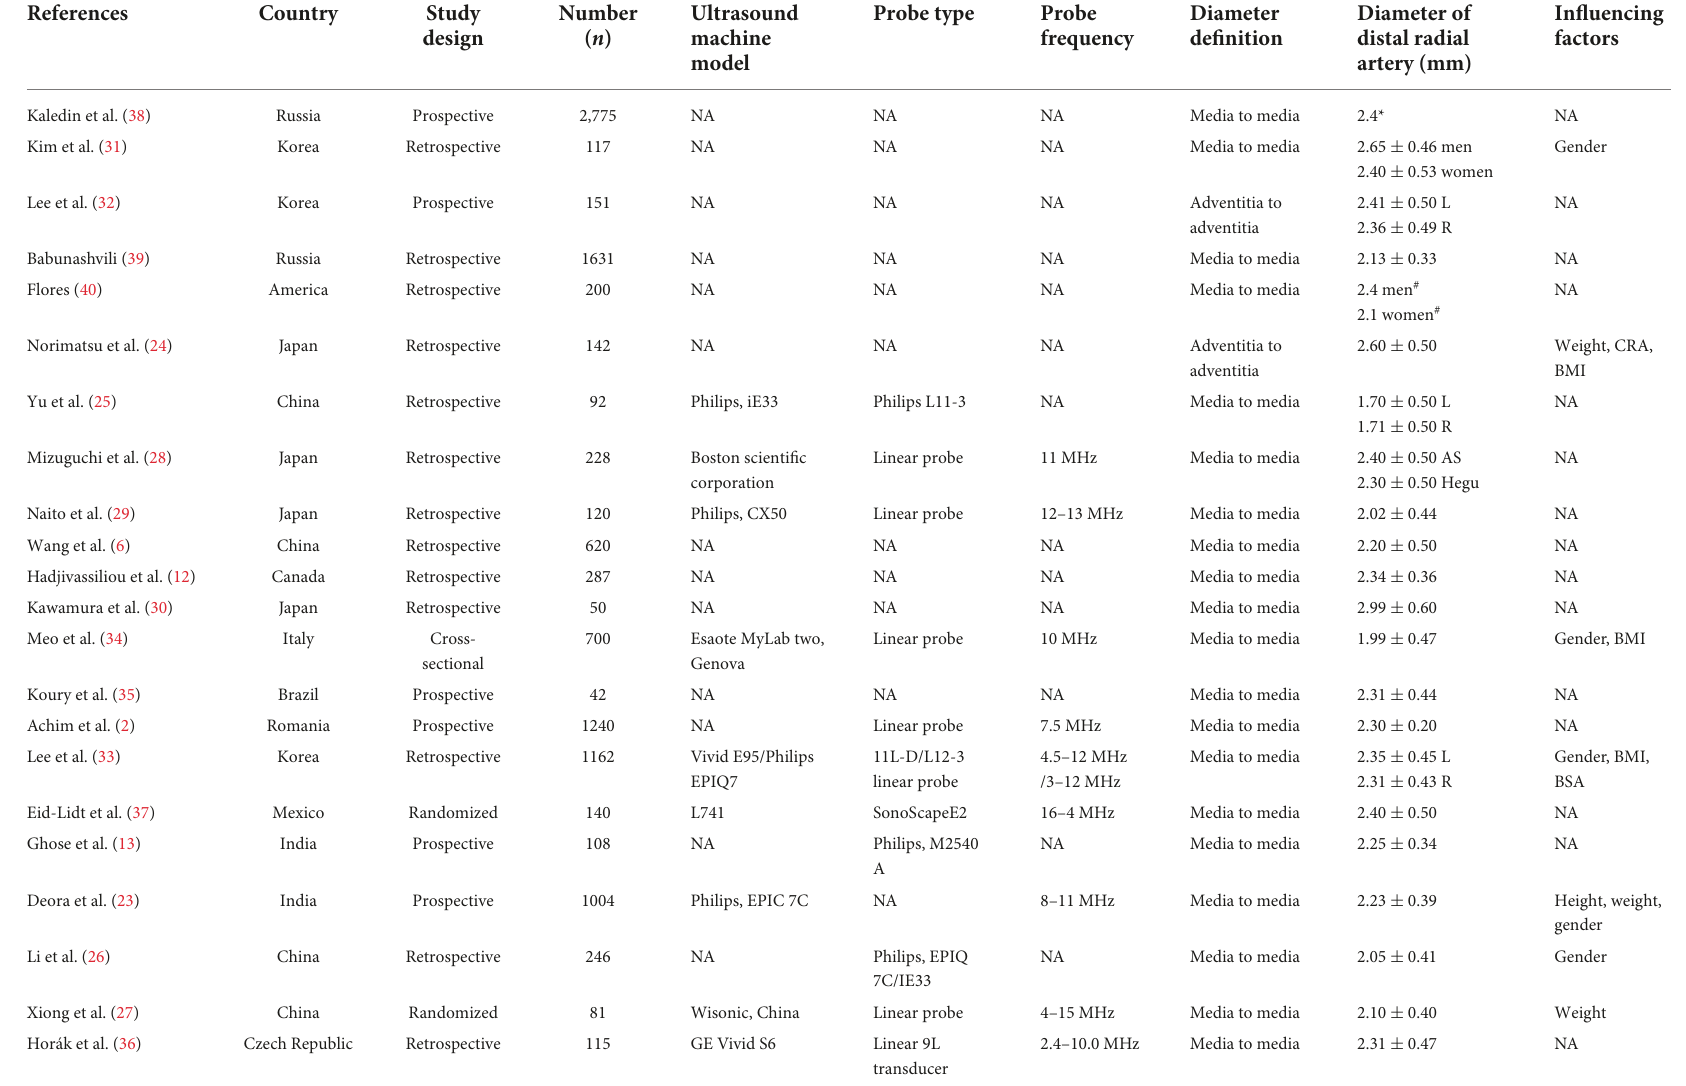
TABLE 1 DRA diameter and the influencing